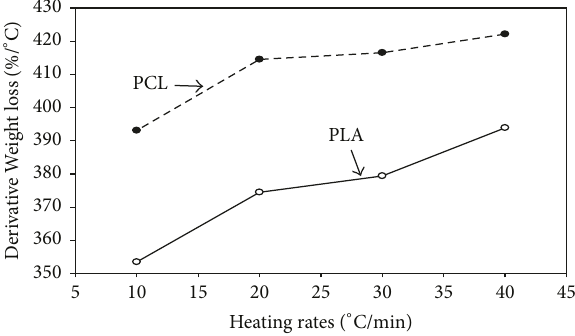
Figure 9: Degradation of PCL and PLA at different heating rates.